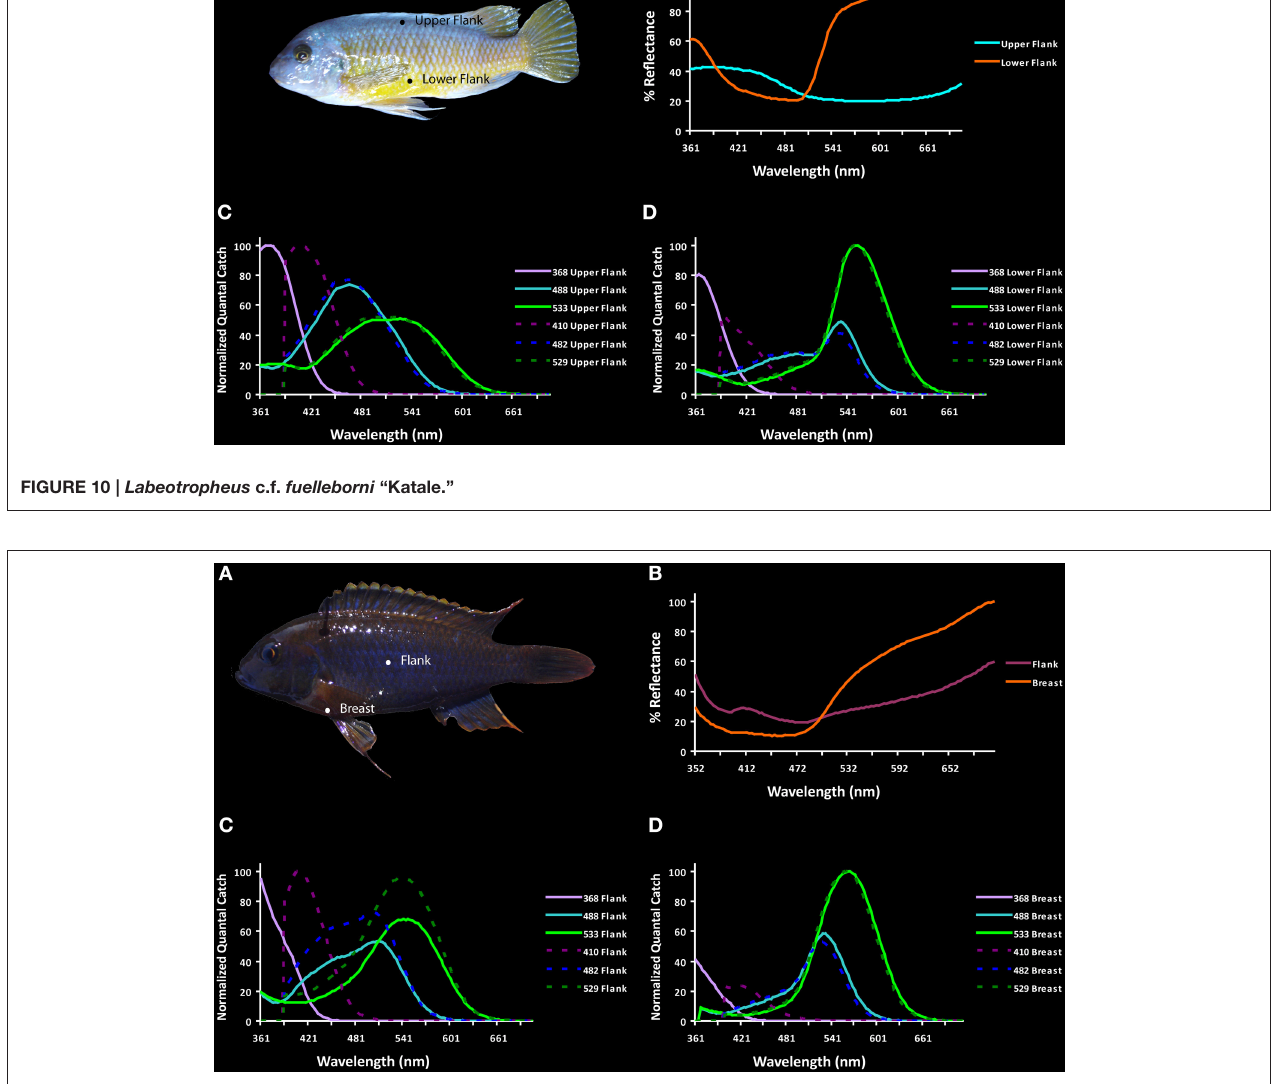
FIGURE 11 | Iodotropheus sprengerae